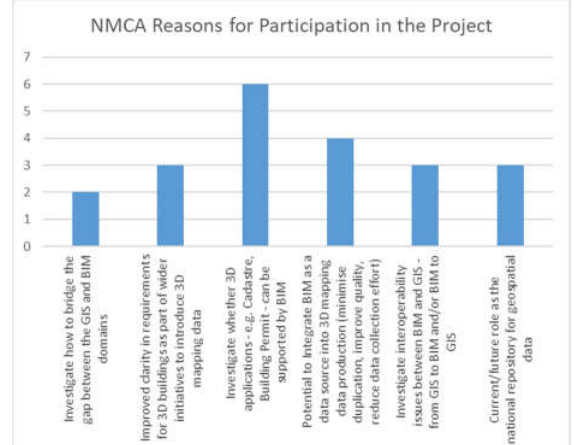
Figure 1 - NMCA Motivation for Participating in the EuroSDR GeoBIM